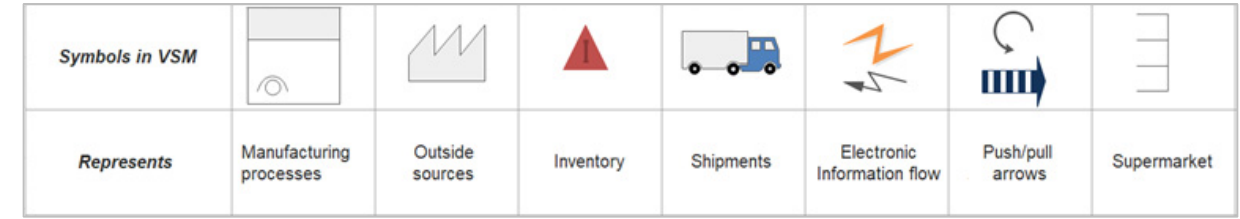
Figure 4. Legend of the map.